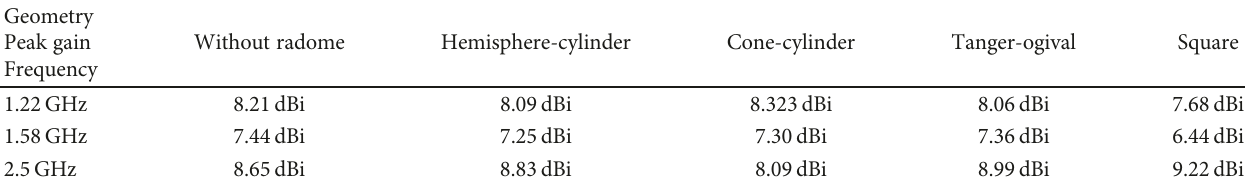
Table 3: Peak gain of di ff erent geometries of radomes at selected